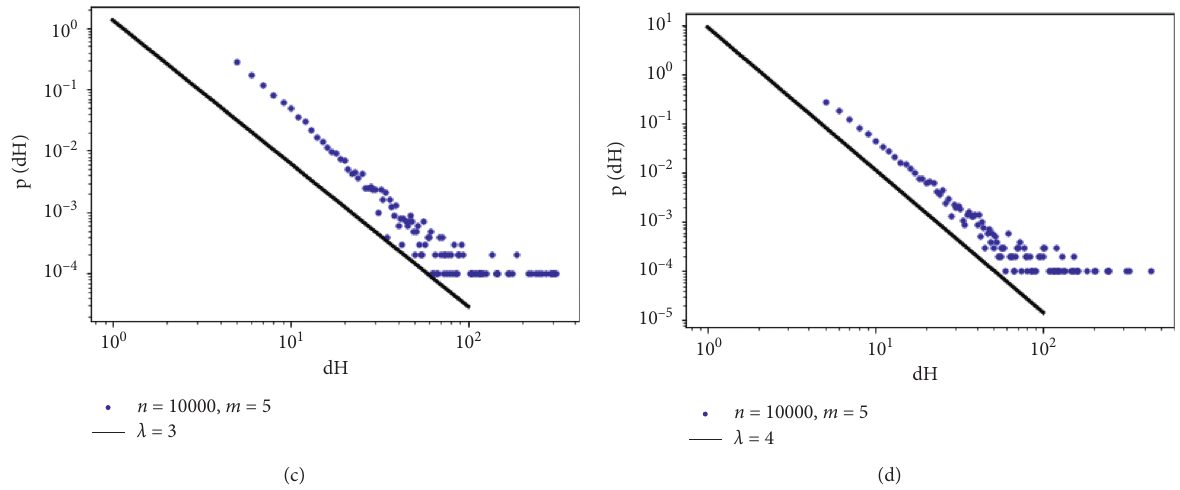
Figure 8: Simulation and theoretical analysis of double logarithmic hyperdegree distribution diagram.